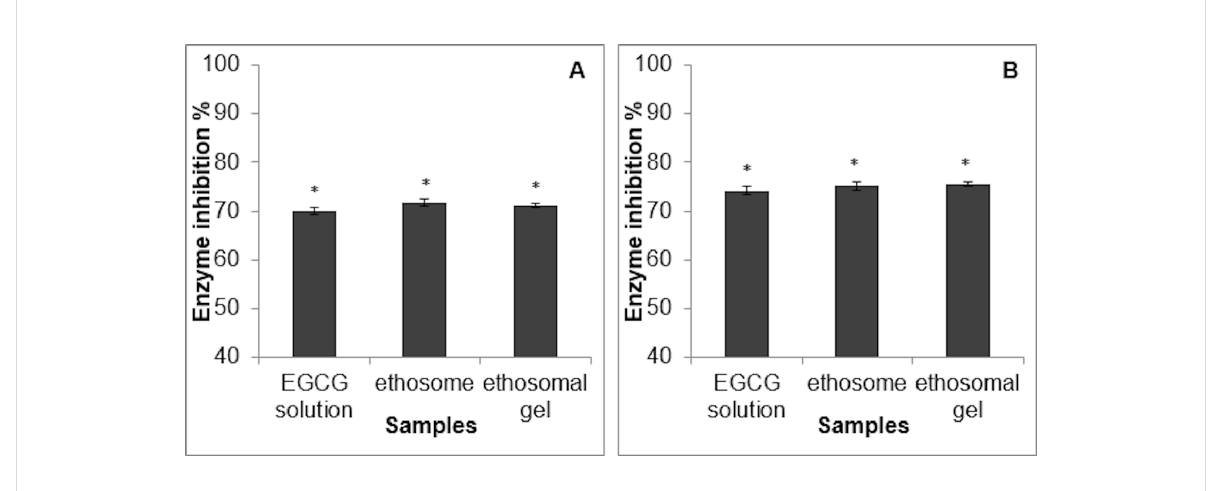
Figure 6: Inhibition values (%) of the: (A) collagenase and (B) elastase enzymes upon exposure to the EGCG solution, ETHs, and ETHGs. (Values are expressed as mean ± standard deviation, n = 3, significantly different groups * p < 0.05.).